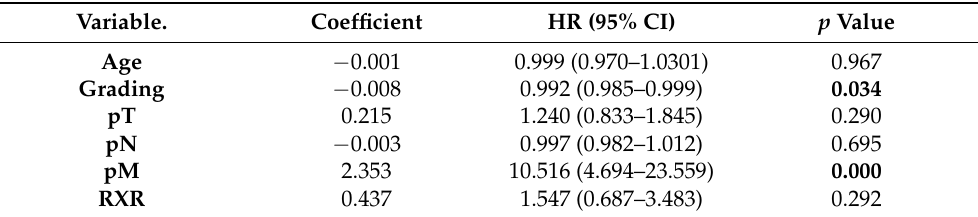
Figure 1. Kaplan–Meier survival analysis among retinoid X receptor (RXR) positive and negative patients. Disease-free survival (DFS) of patients with multifocal and/or multicentric breast cancer (BC). Table 1. Multivariate Cox regression analysis of multifocal and/or multicentric BC patients regard- ing